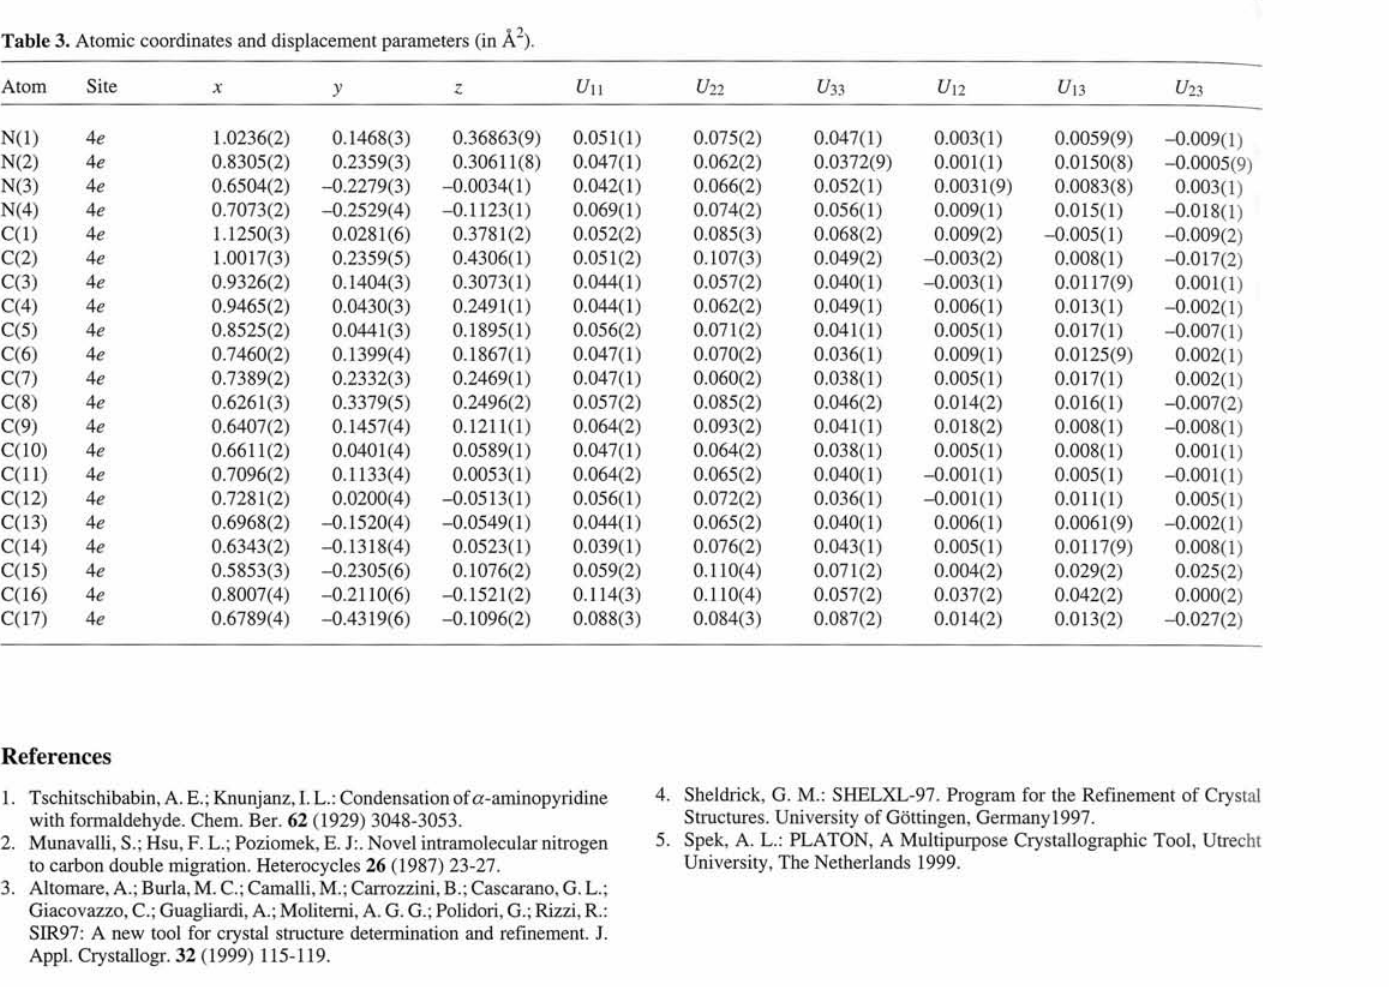
Table 3. Atomic coordinates and displacement parameters (in Á 2